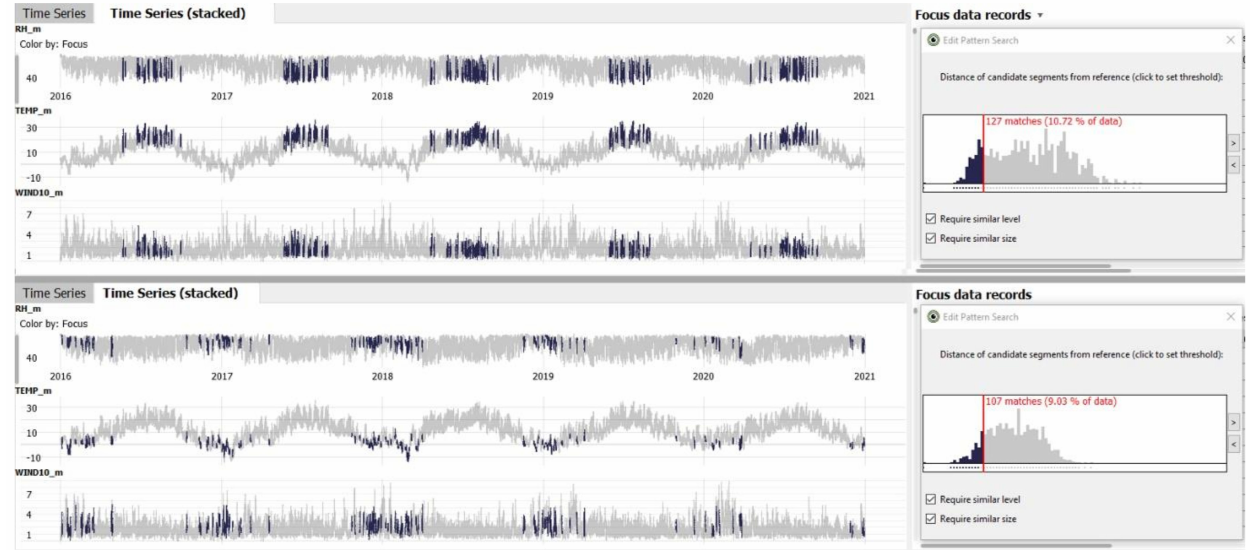
Figure 9. Multivariate pattern analysis of paired parameters for Munich: hot events ( above ), cold events ( below ).